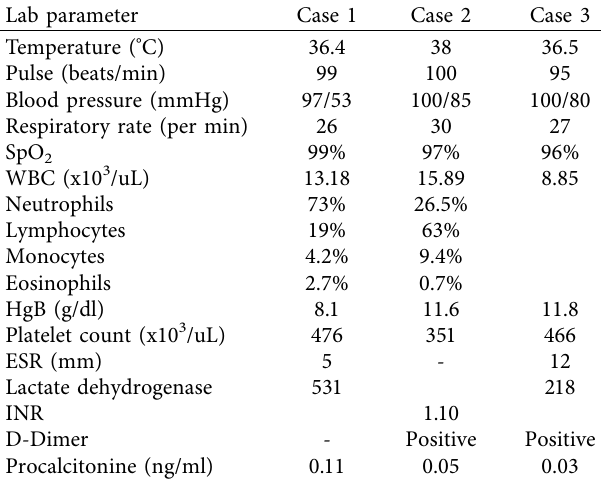
Table 1: The results for blood tests, biomarkers, and inflammatory marker levels for the 3